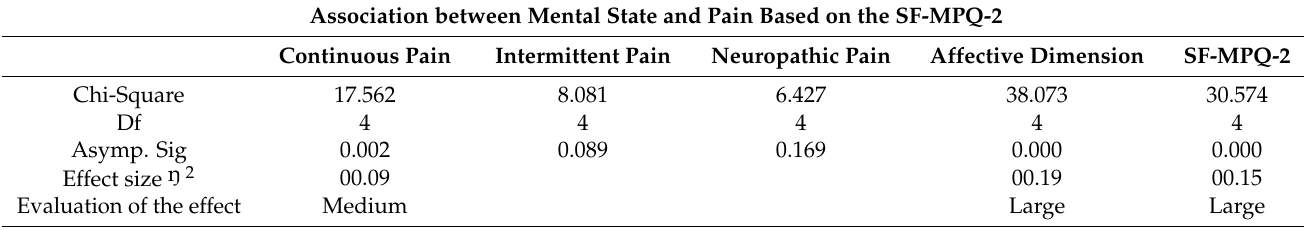
Table 4. Relationship between physical and mental states and the level of pain evaluated using the SF-MPQ-2.